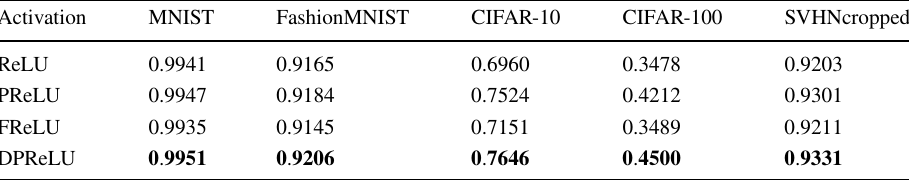
𝛼 and 𝛽 were initialized to the same values as in Fig. 5 and were dynamically changed during training. The same initialization method as in Fig. 5 was applied for each model Bold means the highest value in each column for